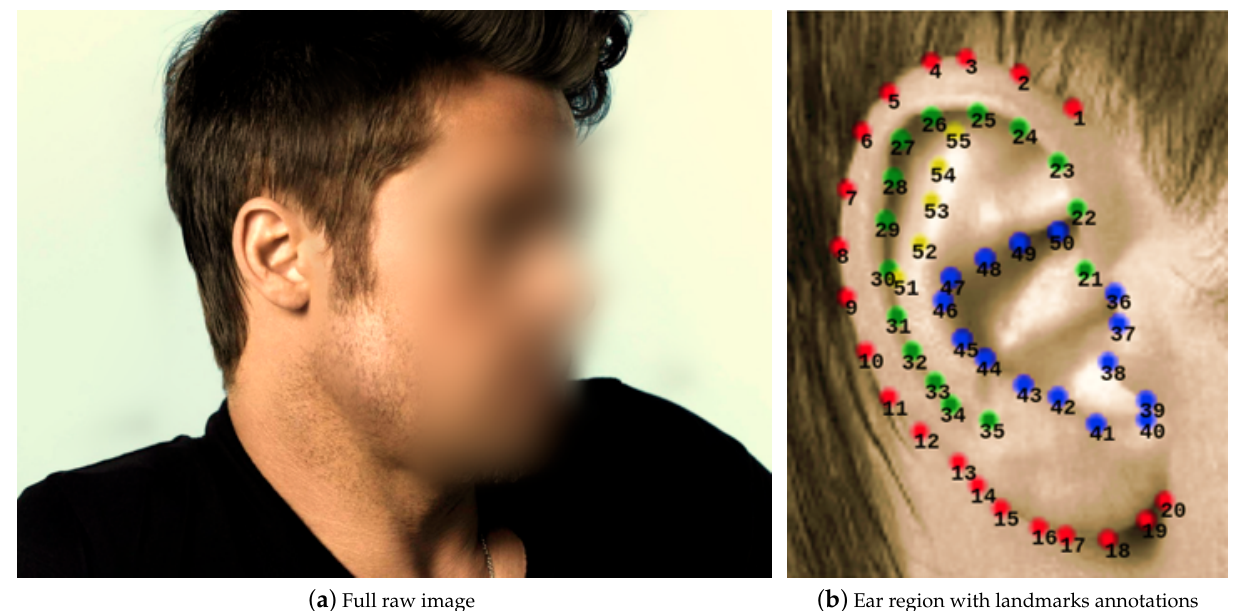
Figure 4. Earlandmarks distribution according to [27]. Note that landmarks from 1 to 20 (red color) define the helix’s outer part and the lobe. From 21 to 35 (green color), define the inner part of the helix. from 36 to 50 (blue color), define the concha and the antihelix. Landmarks 35 to 38 define the tragus, and landmarks 40 to 42 define the antitragus. Finally, from 51 to 55 (yellow color) define the upper crus of the helix. Images elaborated by the